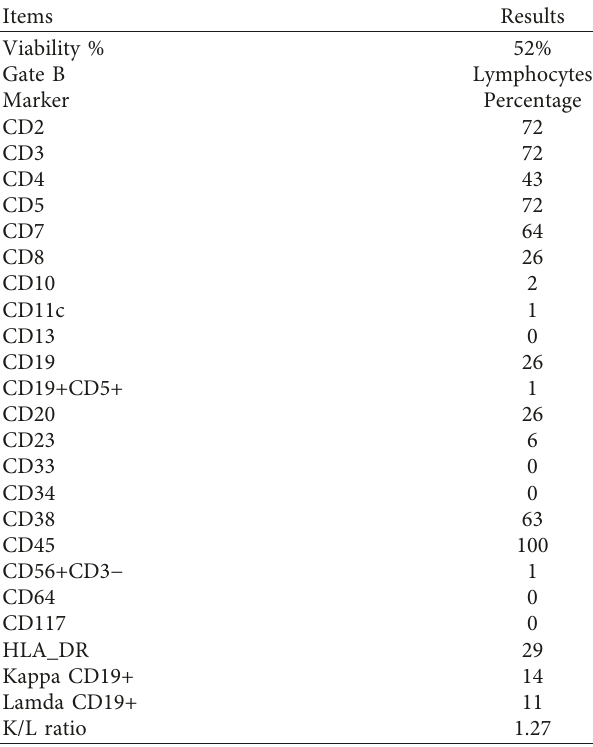
Table 3: Leukemia/lymphoma evaluation.